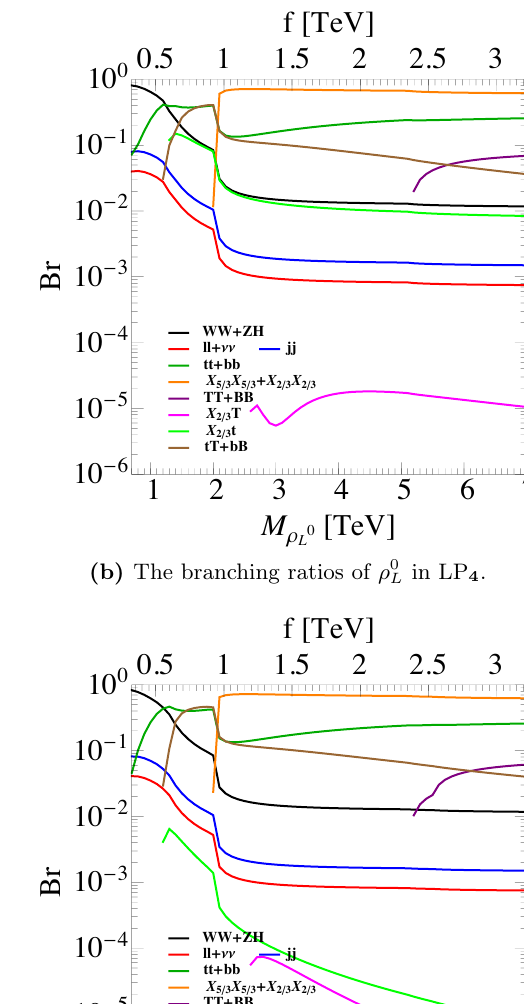
in LF 4 . (d) The branching ratios of (cid:26) 0 L resonances. The parameters are g (cid:26) L